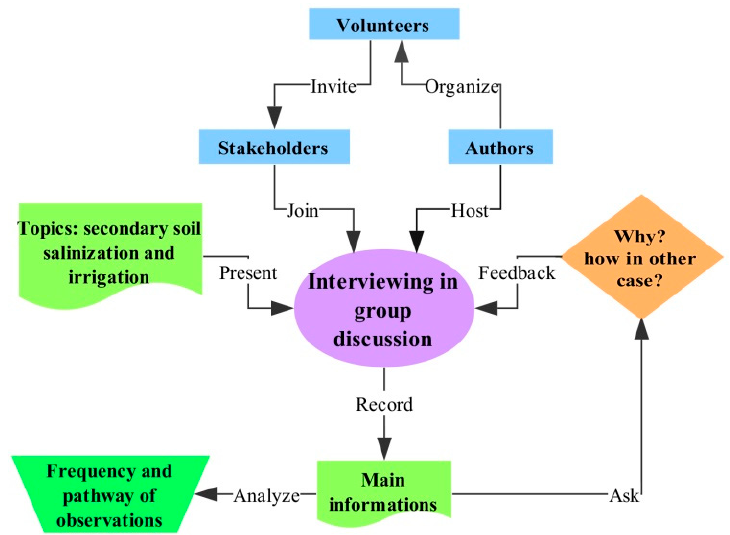
Figure 3. Diagram of the consultation of stakeholders in order to investigate traditional knowledge and irrigation salinity knowledge, adapted from